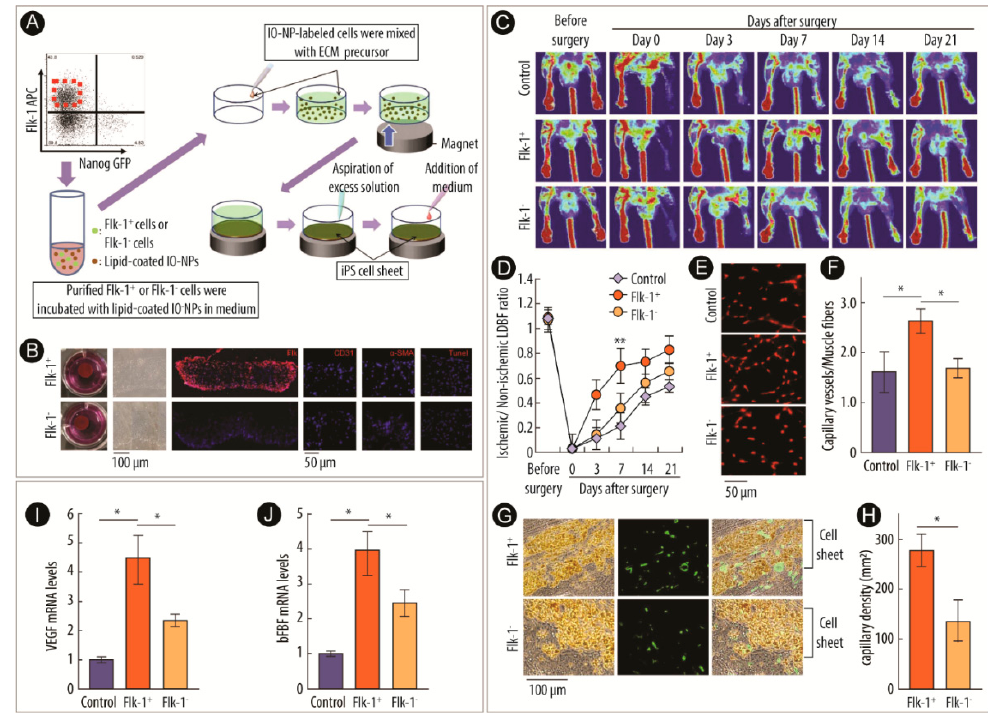
Figure 4. Induced pluripotent stem cell (iPSC) sheet created by employing iron-oxide nanoparticles (IO-NPs) for reparative angiogenesis. Construction of iPSC-derived cell sheet by incubating fetal liver kinase-1 positive or negative (Flk-1 + or Flk-1 − ) cells with lipid-coated IO-NPs, followed by combining with extracellular matrix (ECM) precursor ( A ). Histological examination of iPSC cell sheets, showing the sheet, bright-field imaging of cell layers, and staining with Flk-1, CD31, α SMA, and TUNEL, respectively ( B ). Laser Doppler blood flow (LDBF) images after treatment with ECM precursor gel sheet (control), Flk-1 + cell sheet, and Flk-1 − cell sheet ( C ). Quantitative analysis of ischemic/normal LDBF ratio ( D ); * p < 0.05, ** p < 0.001 vs. control and Flk-1 − . Photograph of capillary networks (red = CD31) on day 21 ( E ). Quantitative analysis of capillary density in ischemic tissue ( F ). Photograph of capillary networks within and around the cell sheet (green = CD31) on day 21 ( G ). Quantitative analysis of capillary density ( H ). VEGF ( I ) and basic fibroblast growth factor (bFGF) ( J ) messenger RNA (mRNA) levels in ischemic hindlimb muscles on day seven, normalized to GAPDH mRNA levels. Reprinted with permission from Reference [92]. Copyright 2013, Springer Nature.